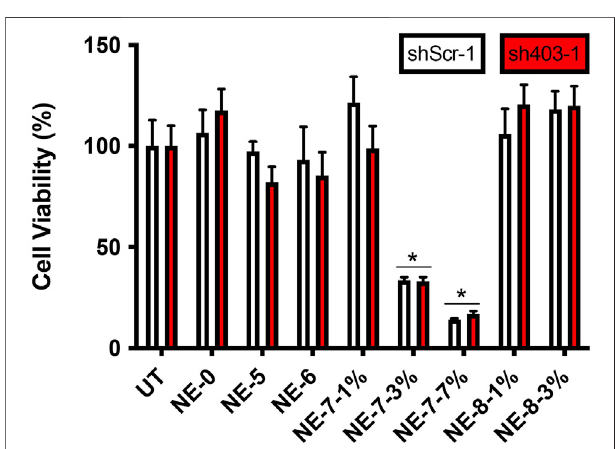
FIGURE 2 | Cell viability in control (shScr-1) and ATP13A2-depleted (sh403-1) M17 cells, in the absence (UT) or presence of NE-0, NE-5, NE-6, NE-7 and NE-8 after 24 h * p < 0.05 compared with untreated